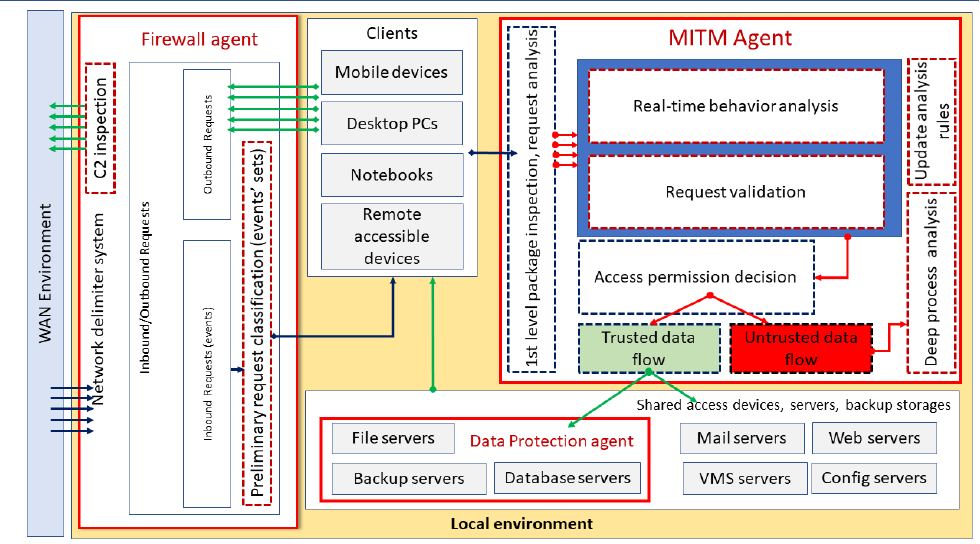
Figure 12. Operation model of autonomous